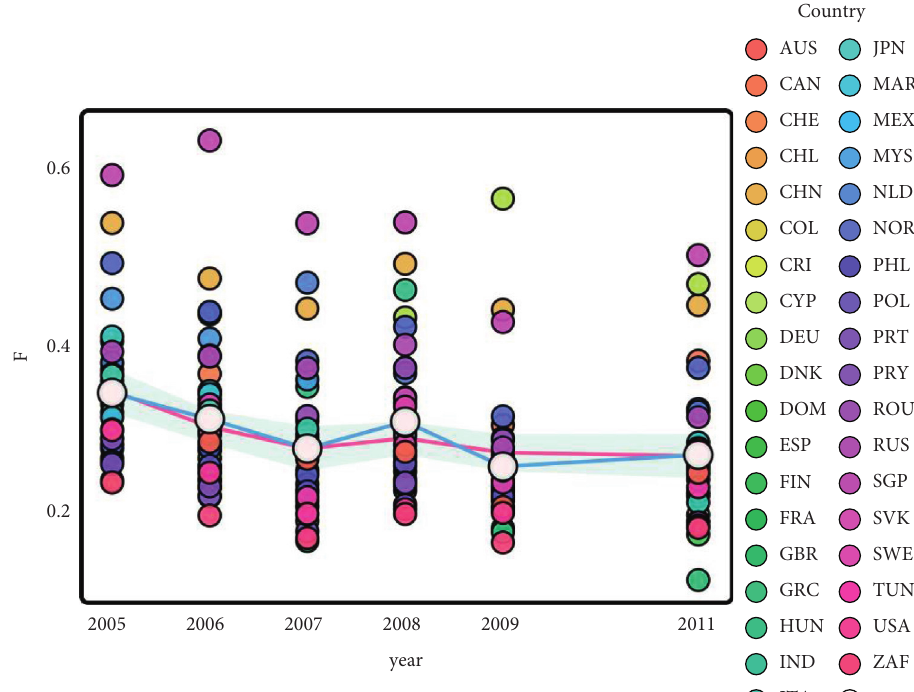
Figure 6: Country resilience scores during the financial